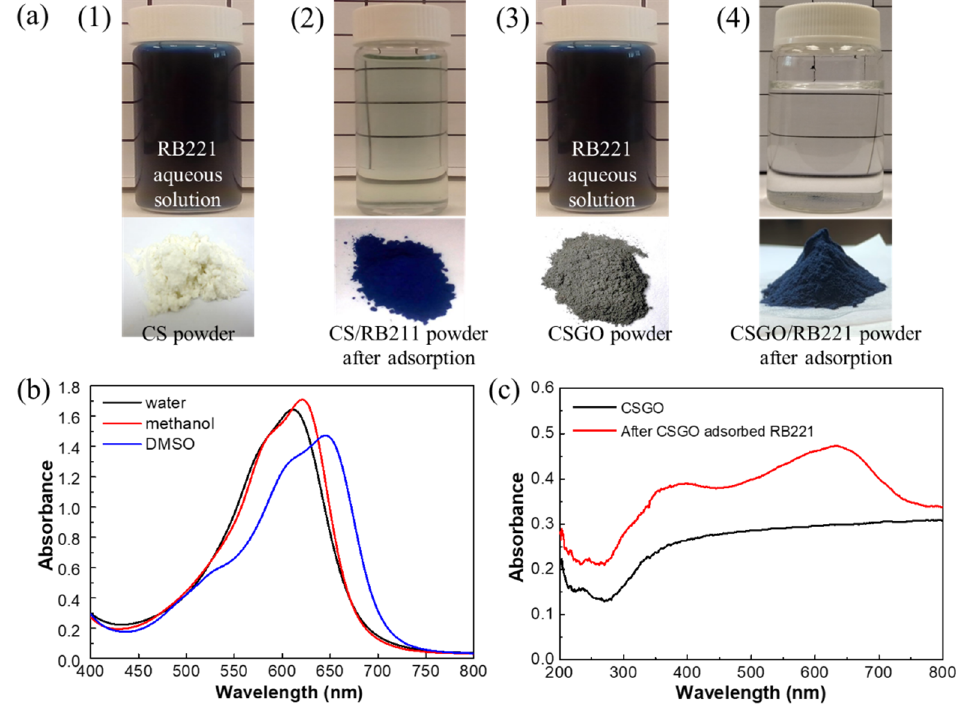
Figure 4. ( a ) Photographs of RB221 aqueous solutions and adsorbents before and after RB221 was adsorbed by di ff erent adsorbents: (1) RB221 solution and CS powder before adsorption, (2) RB221 solutionandCS / RB211powderafteradsorption;